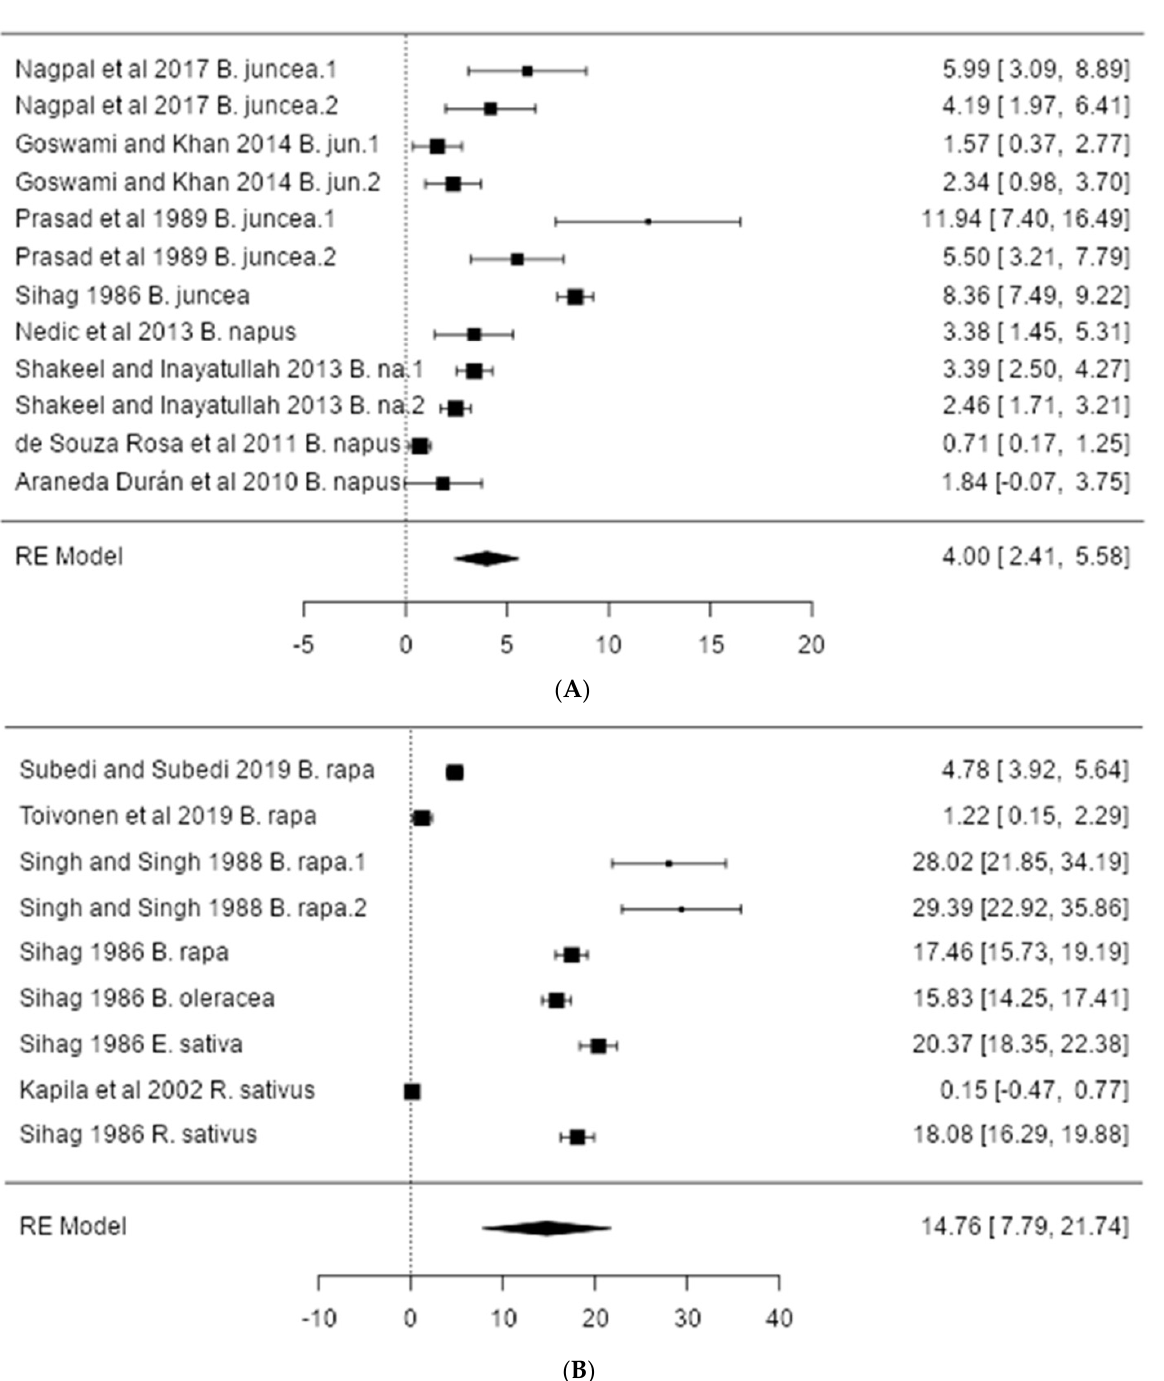
Figure 6. Forest plot of the meta-analysis for the effect of insect pollination on the number of siliquae/plant or area in self-compatible ( A ) and self-incompatible Brassicaceae crops ( B ). In some cases, B. juncea and B. napus were abbreviated to B. jun. and B. na., respectively, to avoid overlapping with error bars and squares.